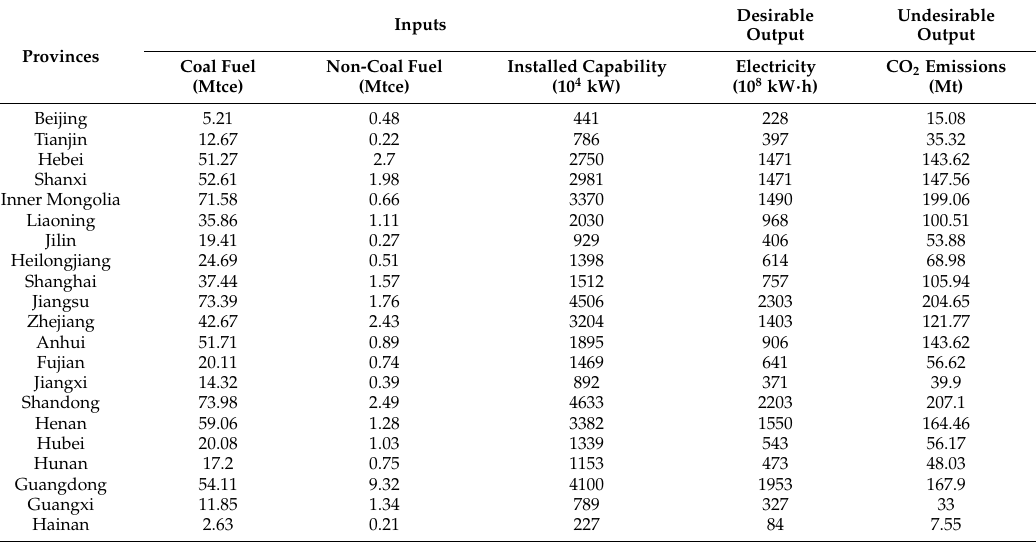
Table 5. Mean values of both inputs and outputs for 30 provincial power grids,